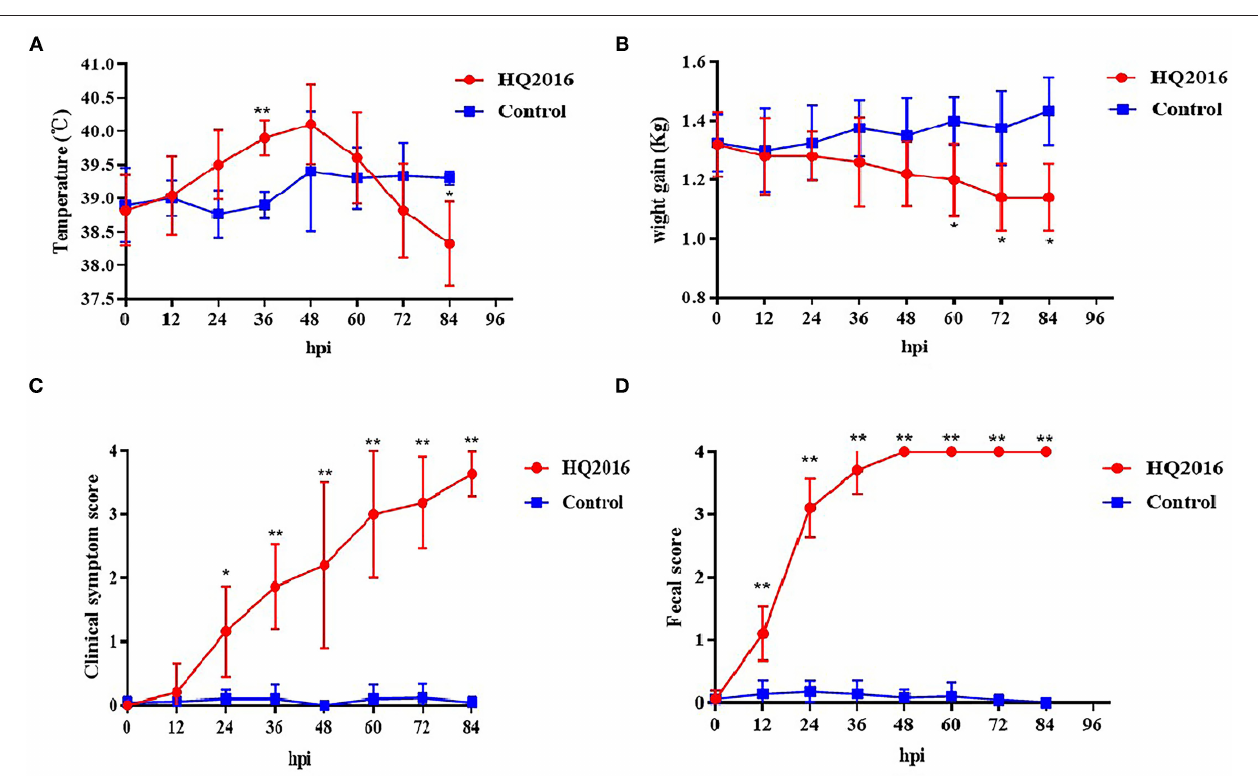
FIGURE 5 | The clinical symptom in the piglets. (A) The temperature changes in different groups. (B) The body weight changes in different groups. (C) The clinical symptom scores in different groups. (D) The fecal scores in different groups. Data are shown as mean standard (* p < 0.05, ** p < 0.01).